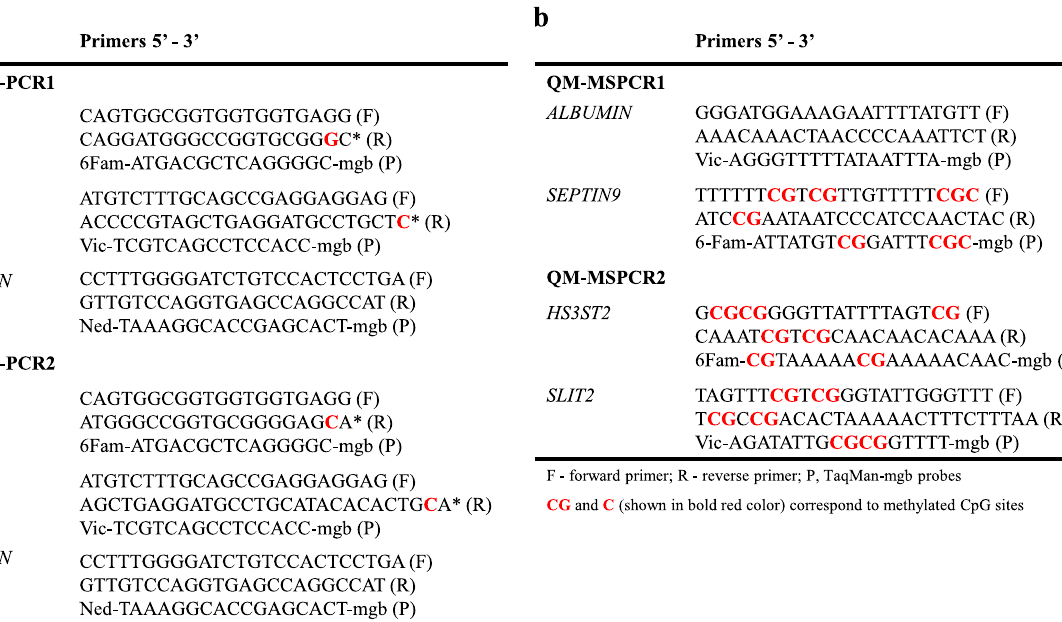
Table 1 Primers sequences for MASO-PCR and